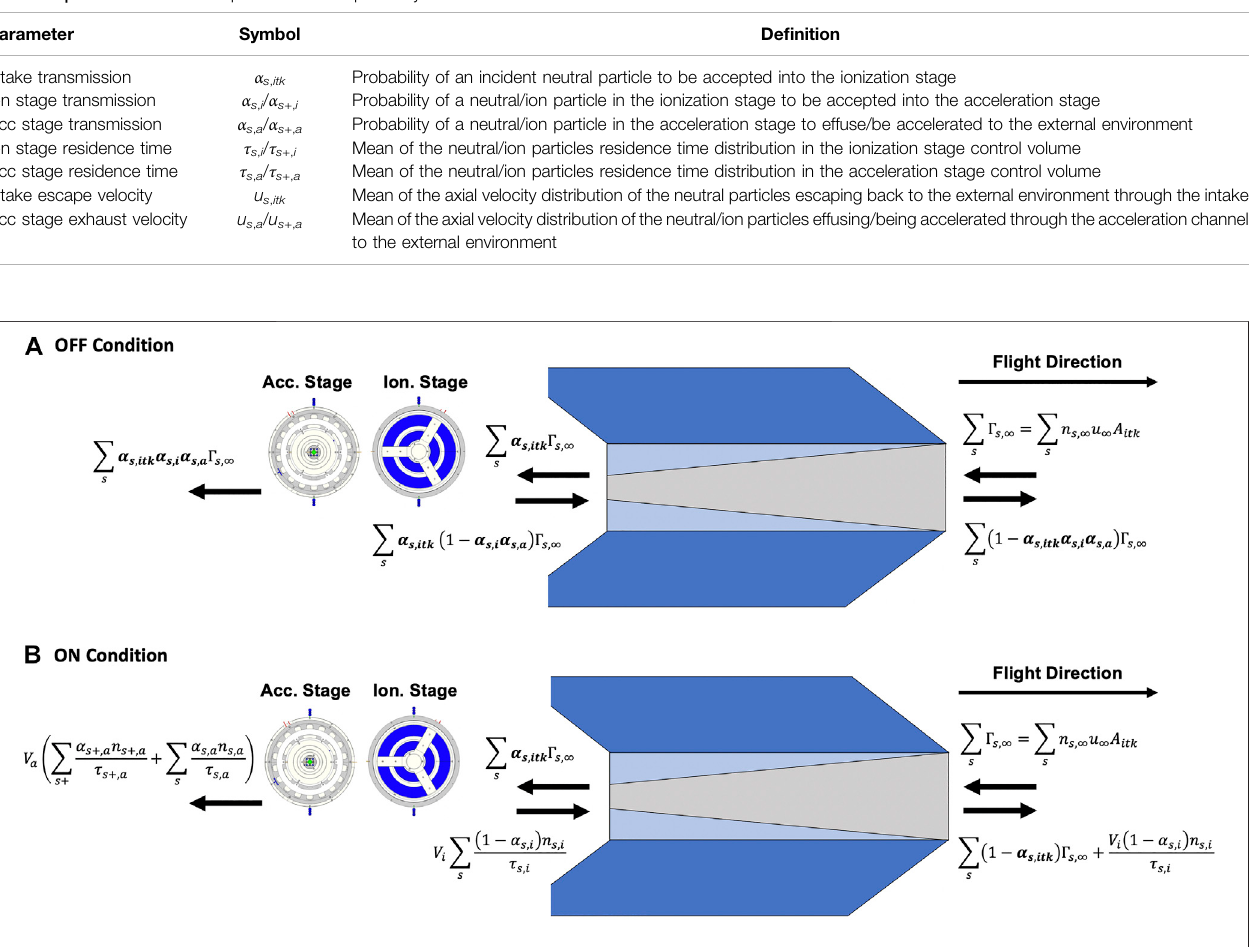
FIGURE4|(A) ParticlecontinuityinintakeandthrustercontrolvolumesinOFFconditionand (B) particlecontinuityinintakeandthrustercontrolvolumesintheON condition.